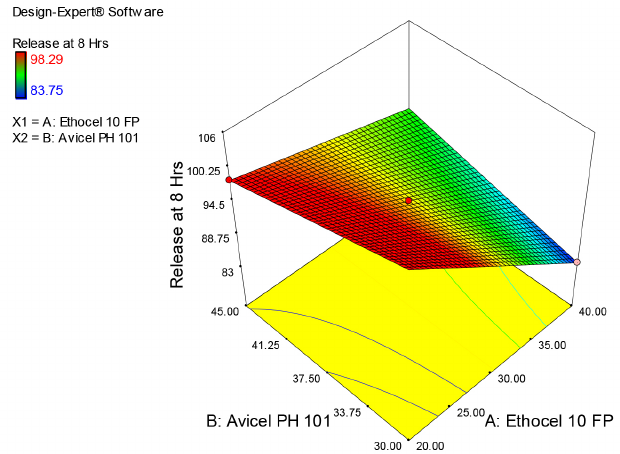
FIGURE 7c - Response surface model (RSM) showing effect of independent variables Ethocel 10FP and Avicel pH 101 on Drug release in 8